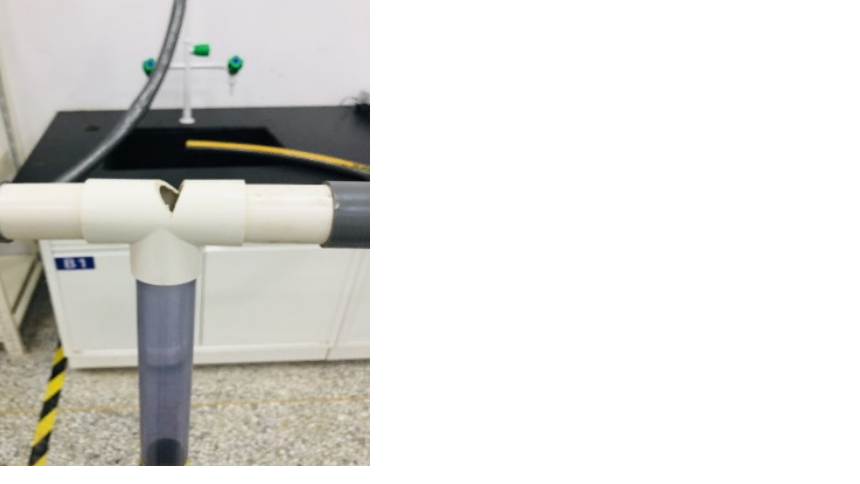
Table 5. A design table of the drainage performance test program of the fiber bundle drainage pipe considering the influence of the drainage pipe diameters, soil properties and strand-shaped fiber bundles.